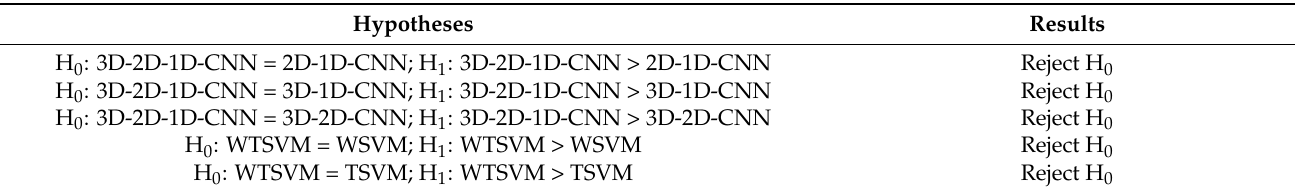
Table 5. Results of hypothesis testing using the Wilcoxon signed-rank test.